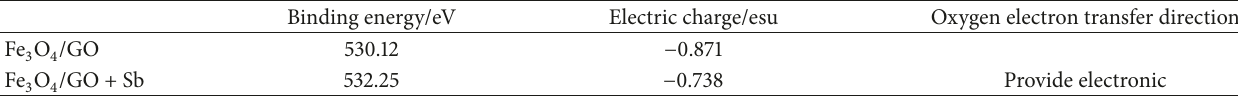
Table 3: Binding energy, charge change, and electron transfer direction of the oxygen atom in the adsorption